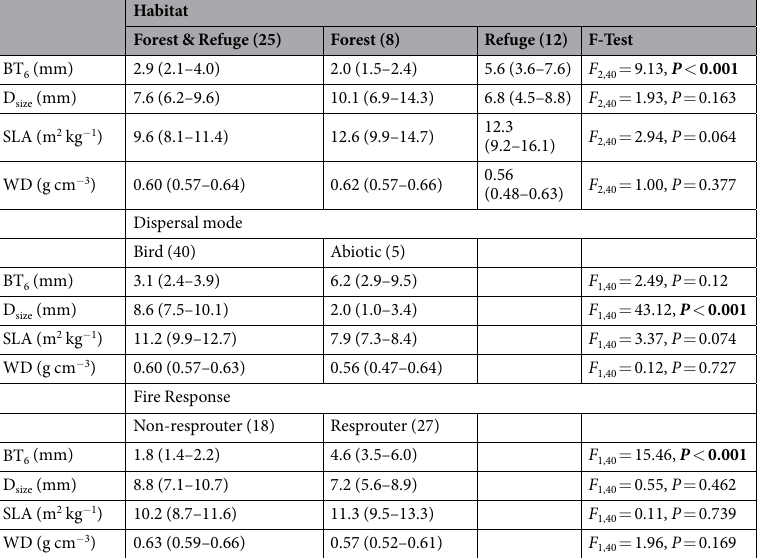
Table 4. Mean (95% CI) bark thickness (BT 6 ), diaspore size (D size ), specific leaf area (SLA) and wood density (WD) and results of the univariate F-tests summarised for the fixed effects of the REML model (habitat, dispersal mode, resprouting response to fire). Forest & Refuge: species recorded from forest and refuge sites; Forest: species recorded from forest only; Refuge: species recorded from refuge sites only. The 95% confidence interval was calculated using a bootstrap method (200 iterations). Sample size is in brackets after fixed effect treatment. Bold type indicates significant effect at P <